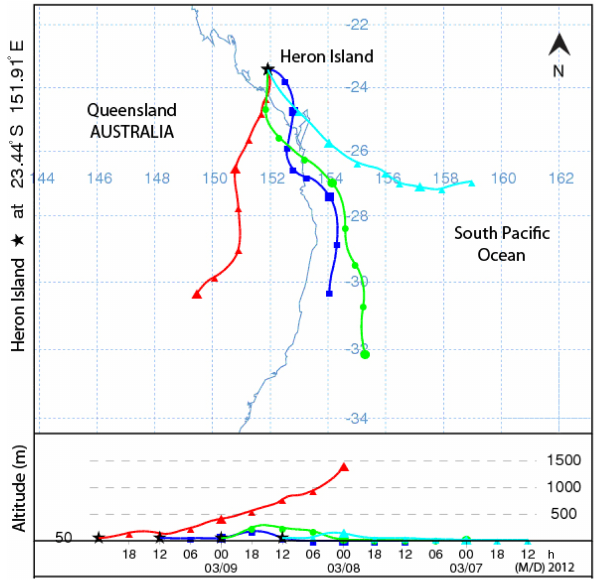
Figure 4. Twelve-hour separated back trajectories of 48h duration ending 10 March 2012 showing air movement onto the Australian continent with high-altitude free-tropospheric air (red line) being directed to Heron Island. This relatively dry non-marine air stream resulted in the lowest DMS a concentration of 0.6nmolm − 3 during the wet season campaign, which occurred shortly after high tide. However, by low tide a DMS a spike peaking at 6.4nmolm − 3 was detected in this air stream under calm conditions (Fig. 3b) prior to a southerly change that redirected the usual marine air flow. The tidal and meteorological conditions under which this DMS a spike was detected strongly suggest that it was derived from the coral reef surrounding Heron Island.